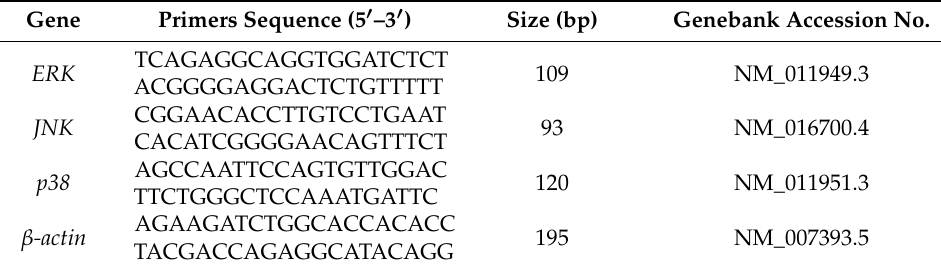
Table 2. Nucleotide sequences of the primers for